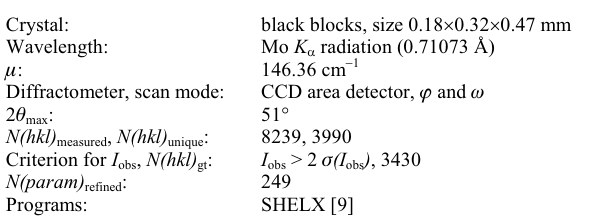
Table 1. Data collection and